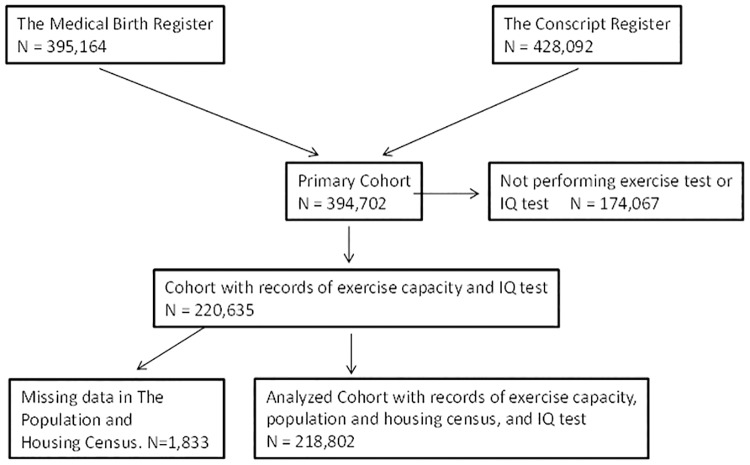
Formation of the study cohort.All men who were registered in both the Medical Birth Register (MBR) and the Conscript Register formed the primary cohort. Men who did not perform the exercise or the IQ test were excluded as well as men with missing data in the Population and Housing Census. Finally, subjects with data in the MBR which were judged as misclassified were excluded.